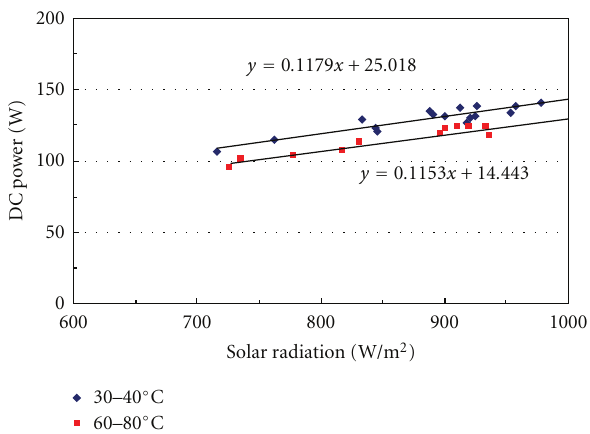
Figure 10: Electrical power of the glazed and unglazed PVT collectors as a function of temperature (solar radiation 950 W/m 2 ).